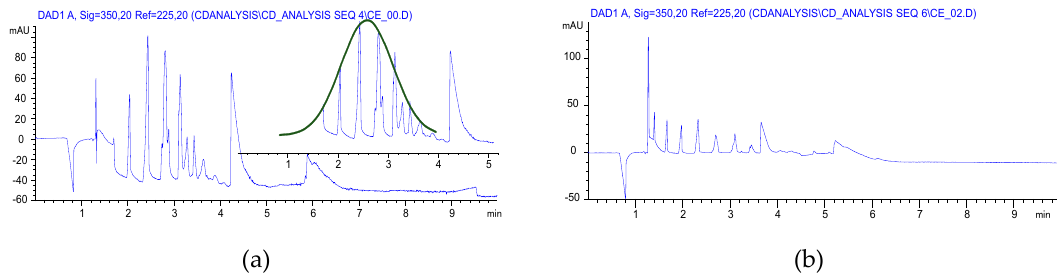
Figure 2. Capillary electropherograms of carboxyethylated β CD ( a ) synthesized in solution (compound 3 , item 8 in Table 1); ( b ) synthesized in ball mill (compound 3 ′ , item 6 in Table 1).